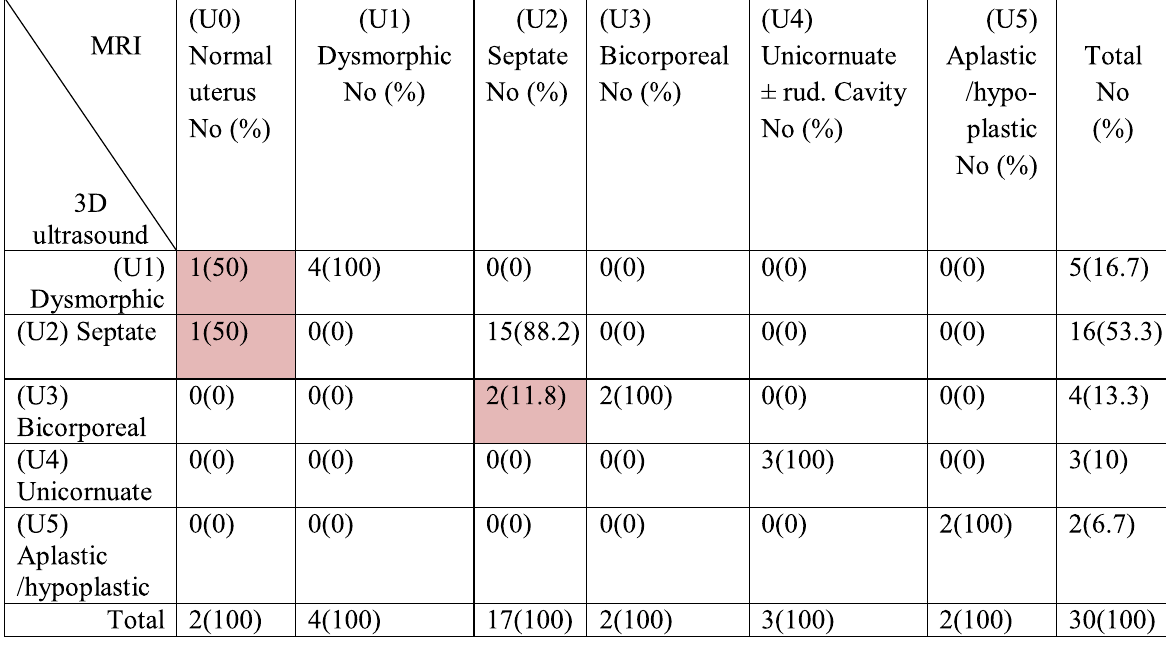
The shaded data represent disaggreement in the diagnosis between MRI and